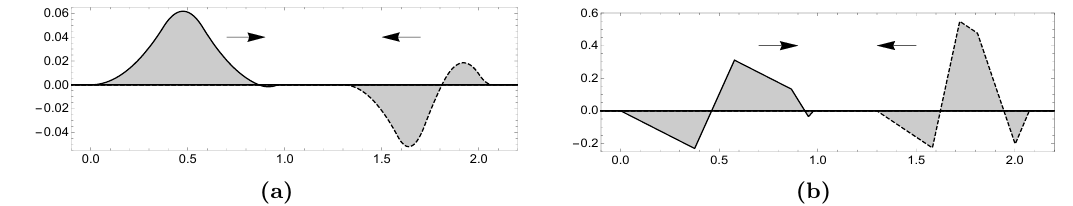
Figure 5 . Initial (cid:12)eld con(cid:12)guration (a) (cid:9)( x ) and (b) (cid:9) t ( x ) given by two compact oscillons at t = 0. Parameters of oscillons v 1 = 0 : 3, v 2 = 0 : 34, u 1 = 0 : 5, u 2 = (cid:0) 0 : 7, x 01 = 0, x 02 = (cid:0) 1 : 3 and t 01 = t 02 = 0, (cid:21) i = 1, " i = 1 = (cid:15) i where i = 1 ; 2. where u are boost velocities, t are temporal translations, x are spatial translations, (cid:21) i 0 i 0 i i stand for scale parameters and " = (cid:6) 1 and (cid:15) = (cid:6) 1 for re(cid:13)ections. Let us (cid:12)x the sign of i i v > 0 because (cid:30) ( t; x ; (cid:0) v ) = (cid:30) ( t; 1 (cid:0) x; v ) and so the sign of v can be absorbed into the i combination of spatial re(cid:13)exion and